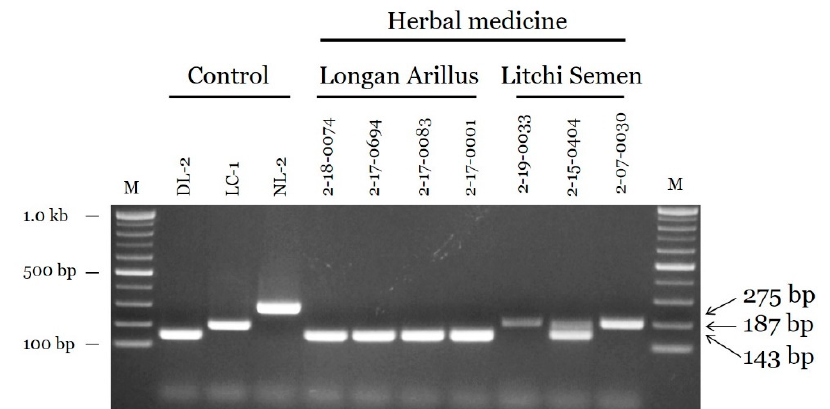
Figure 5. Monitoring of herbal medicines distributed as Longan Arillus and Litchi Semen using the multiplex PCR assay. M: 100 bp DNA size marker (100–1000 bp), DL-2: D. longan , LC-1: L. chinensis , NL-2: N. lappaceum . See the Supplementary Materials Table S1 for more detailed information about control samples. ‘Longan Arillus’ (voucher number: 2-18-0074, 2-17-0694, 2-17-0083, and 2-17-0001) and ‘Litchi Semen’ (voucher number: 2-19-0033, 2-15-0404, and 2-07-0030) are commercial products. Arrowheads indicate the amplified fragment sizes.